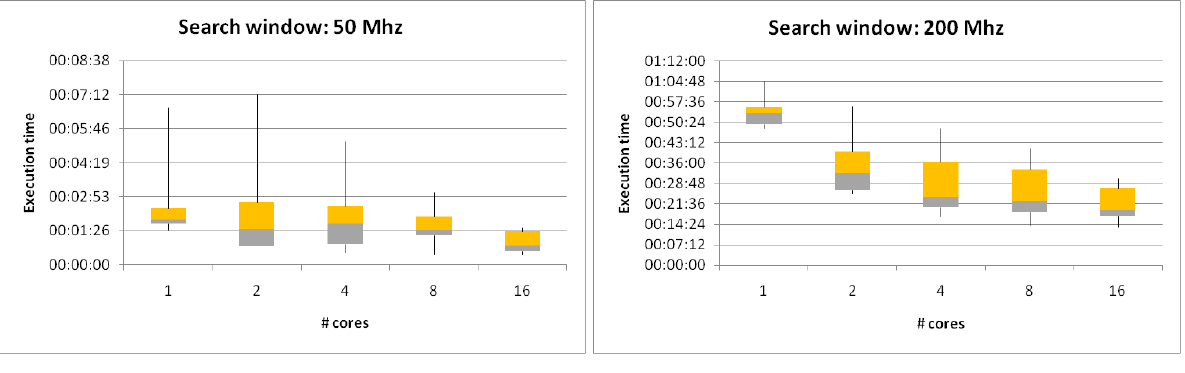
Figure 5. Statistical significance of the